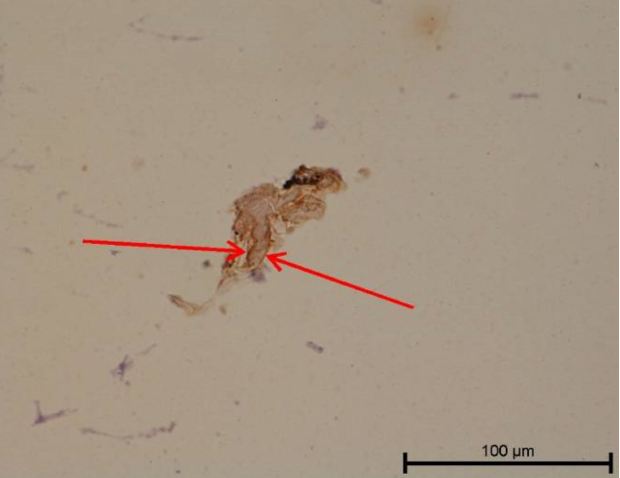
Figure 14. Light microscope image. Carious tooth. Anti-PDPN—positive. Inflammatory infiltration (red arrows). Mag. 400 × .